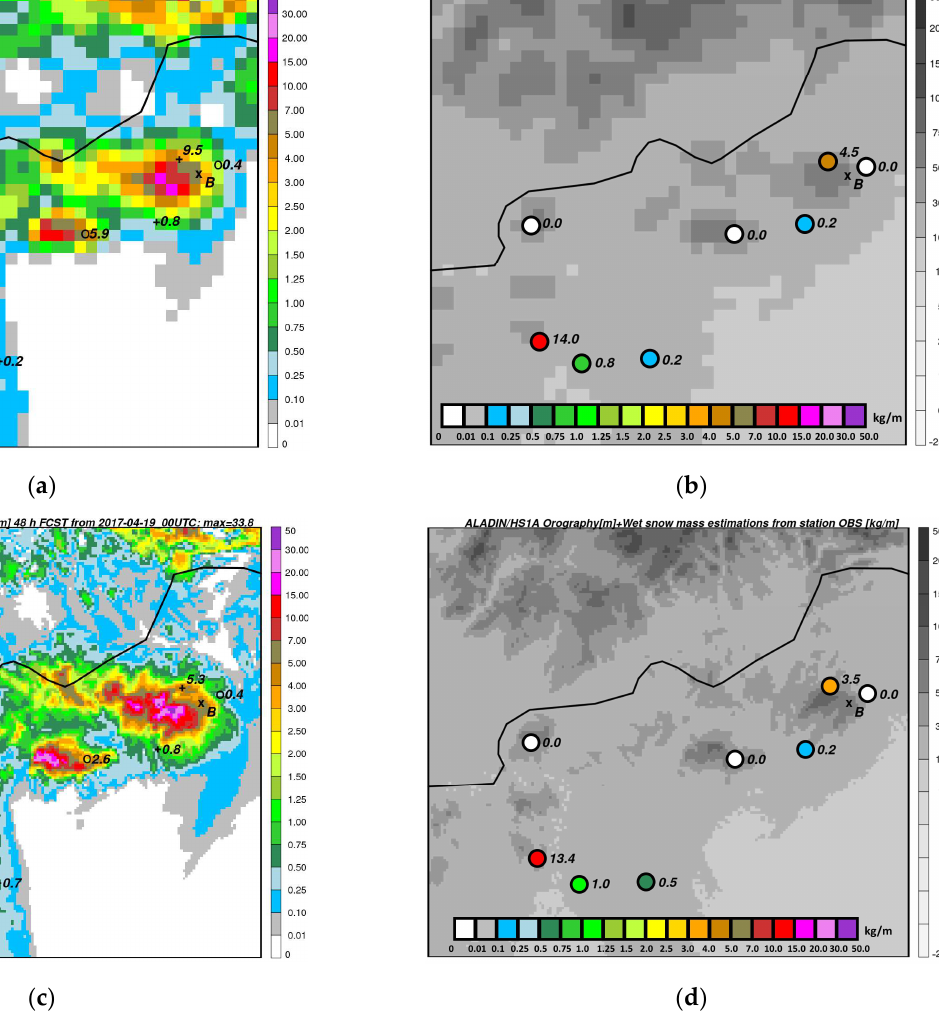
Figure 12. ( a ) Forecast of cumulated wet snow mass (shaded, kg·m −1 ) from the ALADIN/SHMU run based on 19 April 2017 00 UTC and valid for 21 April 2017 00 UTC in the region of northern Hungary (domain shown in Figure 6b). Circles, plus “and X” symbols depict the positions of stations and sites as explained in Figure 3. The numbers are model forecasts of the mass valid for the closest grid-point of height corresponding to station height.; ( b ) ALADIN/SHMU model orography (shaded, m). Numbers and colored circles show the mass (kg·m −1 ) estimated from both station observations and ALADIN/SHMU data and cumulated for the same period as in a).; ( c ) as in ( a ) but for the ALADIN/HS1A model run.; ( d ) as in ( b ) but for estimations using ALADIN/HS1A inputs.